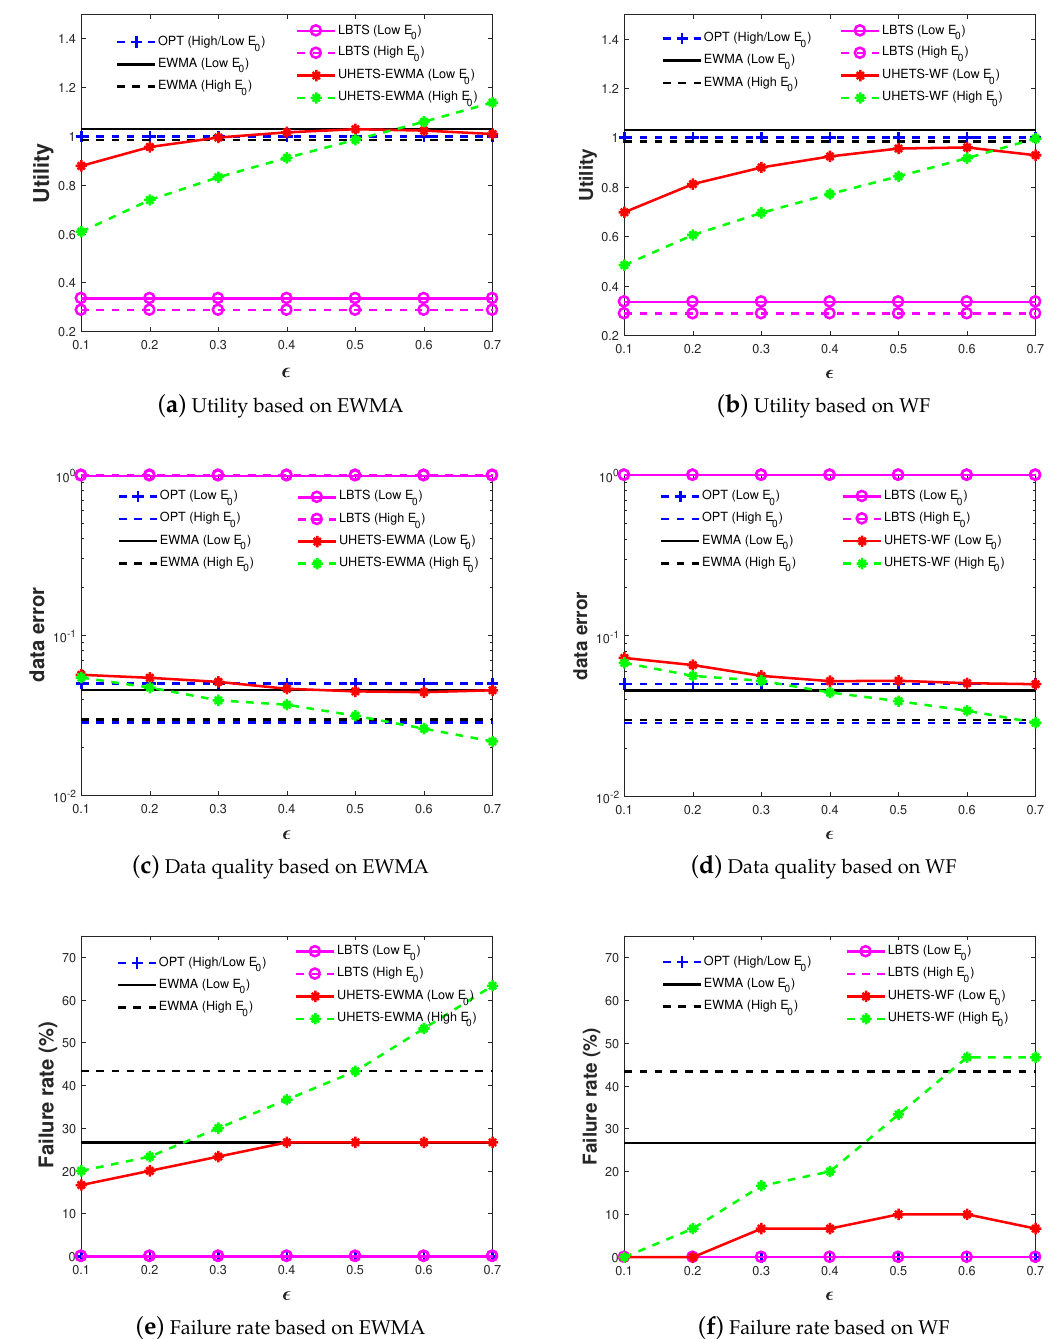
Figure 9. Statistic performance: comparison of Uncertain Harvested Energy-based Transmission Scheduling (UHETS) based on EWMA or WF with pure EWMA, Lower Bound-based Transmission Scheduling (LBTS), and